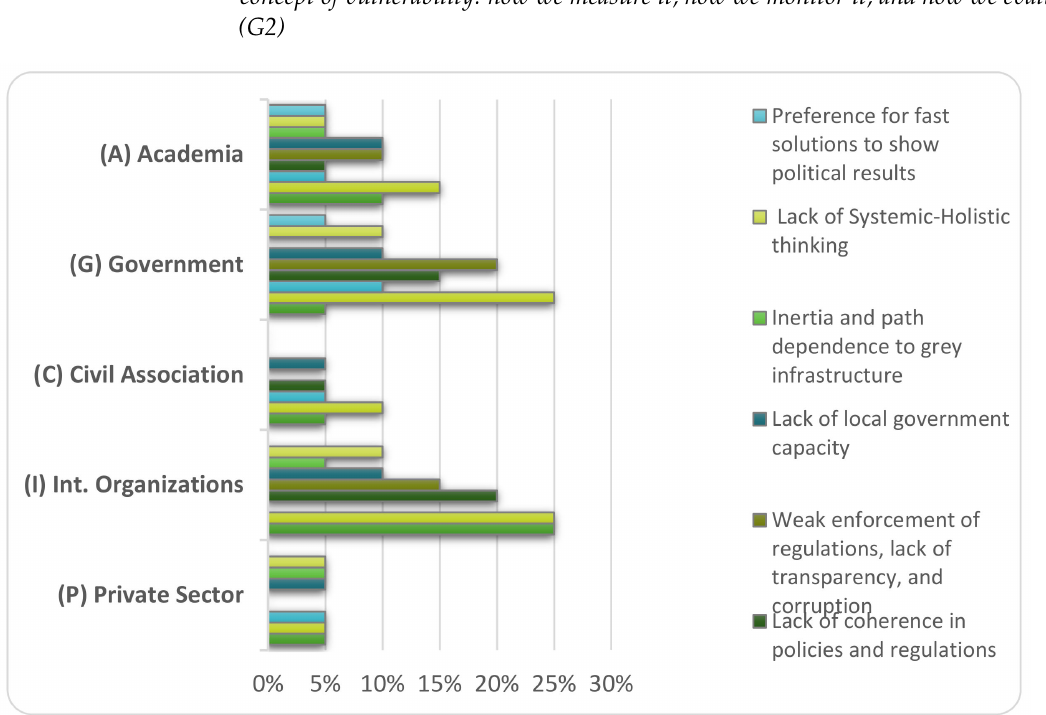
Figure 4. Governance and institutional barriers perceived per group of stakeholders. Source: Authors